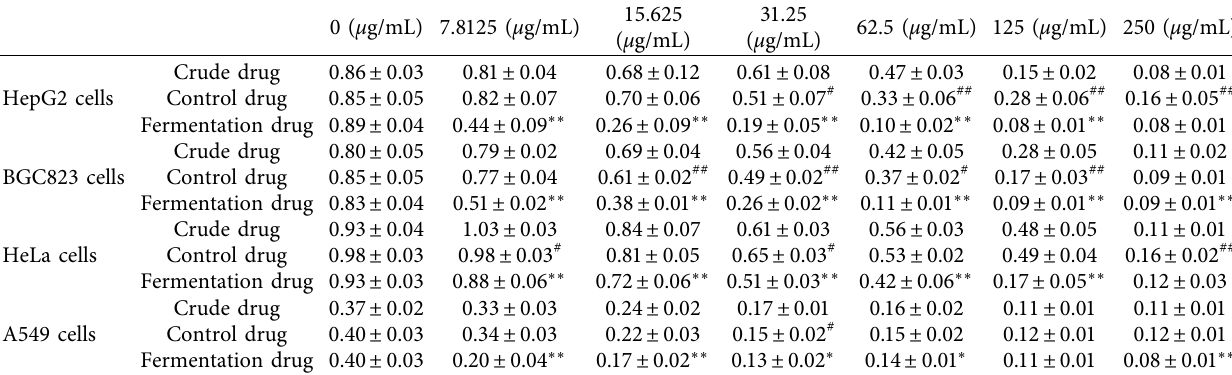
Table 1: The OD value of different drug concentrations.